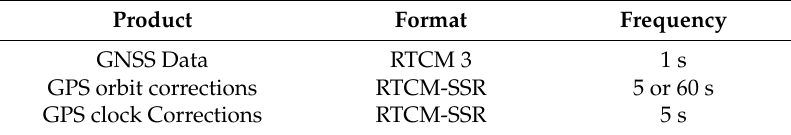
Table 1. Outlines the IGS RTS products, their formats and